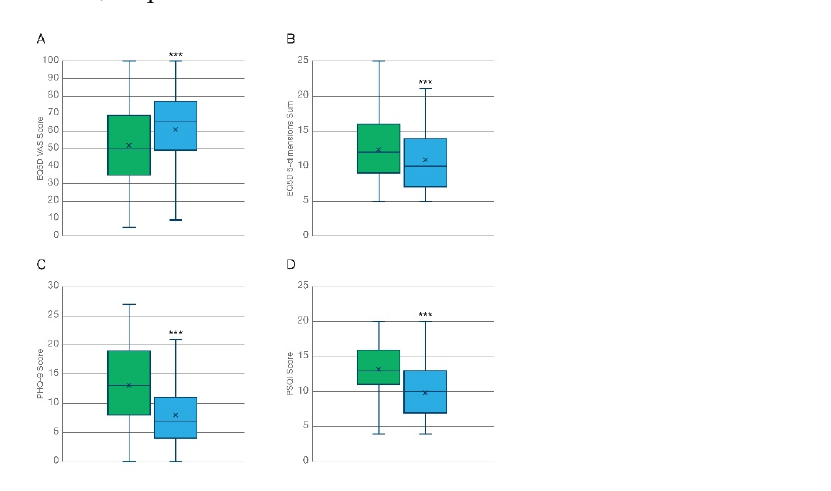
Figure 2. Improvement of general health outcome measures at the 3-month follow-up. Analysis of PROMS shows how the inhalation of KHIRON 20/1 was associated with a marked improvement in self-reported health related QoL (N = 344) measured as ( A ) the scoring of the VAS of the EQ5D, and ( B ) the sum of the 5 dimensions of the EQ5D questionnaire. ( C ) General mood/ clinical depression assessed with the PHQ-9 scale (N = 339) was markedly improved. This effect was mainly driven by patients diagnosed with anxiety-related disorders (Table 2). ( D ) Quality of sleep assessed with the Pittsburgh Sleep Quality Index (N = 344) was improved by the treatment with inhaled chemotype 1 cannabis flos. *** p < 0.001.